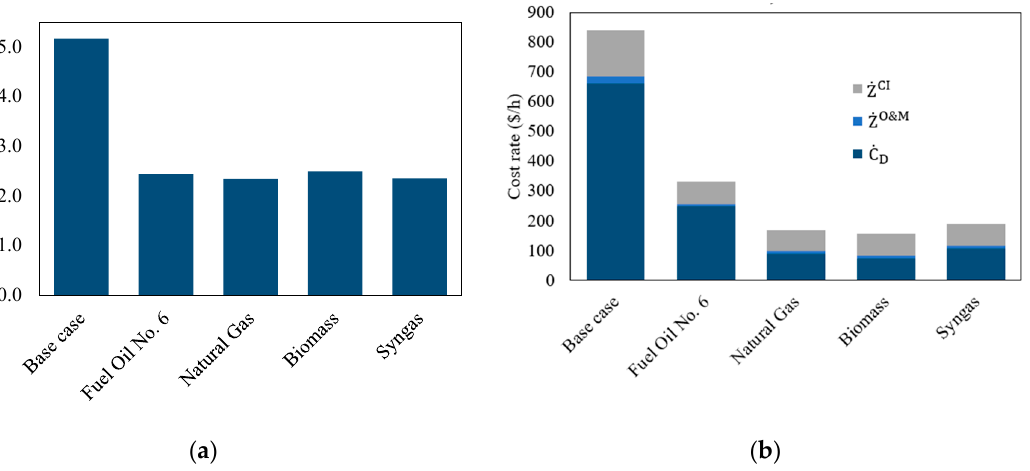
Figure 5. Comparison of ( a ) Total investment cost of the plant and ( b ) Exergy destruction, investment, and O&M cost rates of the CCHP system based on different fuels.